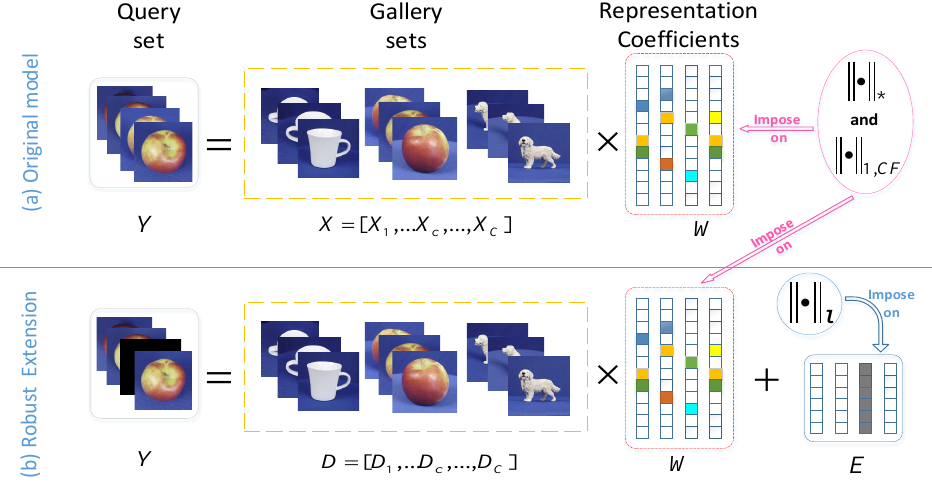
Figure 1. The flowchart of the proposed models: ( a ) Low Rank regularization on Class-level Sparse joint representation model (LRCS). ( b ) Extended robust model with related regularizations on the error term for different types of gross